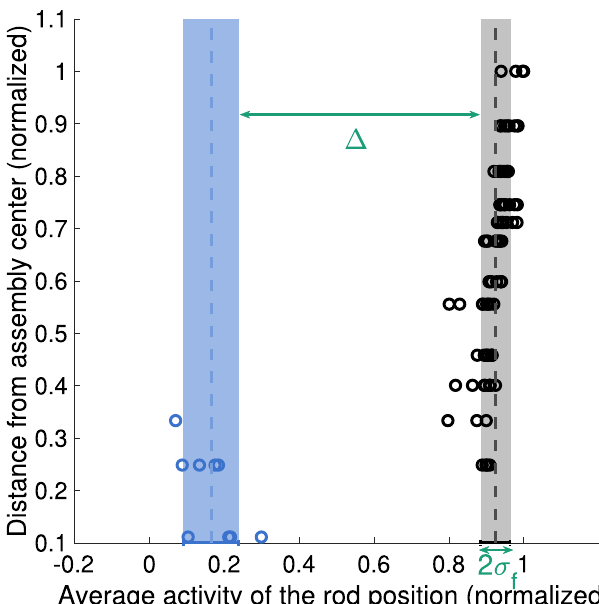
Figure 1. Illustration of image quality index, on a plane of average activity of the fuel grid positions versus the distance from the assembly center. Circles represent individual grid positions, colors denoting the type (black for filled grid position, blue for empty grid position). The mean average activity ( µ e and µ f ) of both the empty grid positions and the filled grid positions is marked with a dashed line (blue and black, respectively). Standard deviations ( σ e and σ f ) of these two groups are marked with bands of corresponding colors. Twice the standard deviation of the full-length rods is marked with a green arrow and “2 σ f ”, illustrating the second part of the image quality index [ (cid:31) , σ f ] . The “ (cid:31) ” index is marked with a green